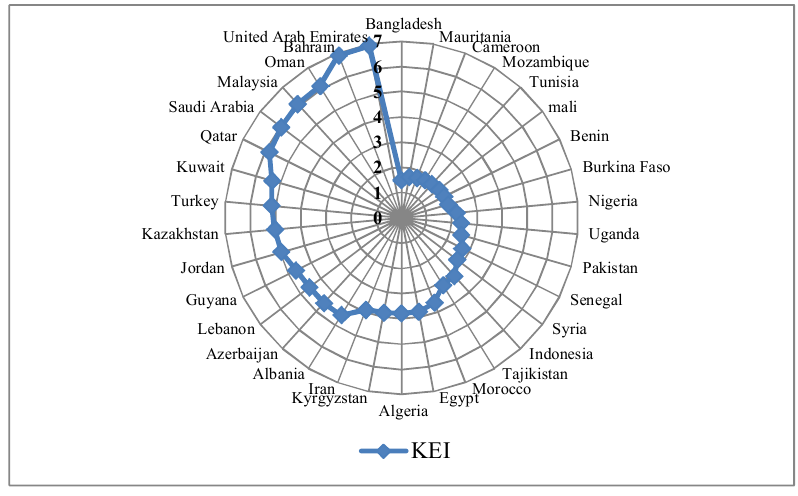
Fig. 2. Position of KEI in OIC